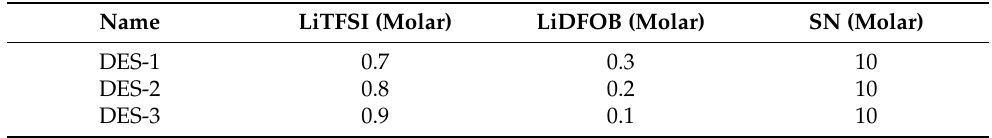
Table 1. The composition of different DES